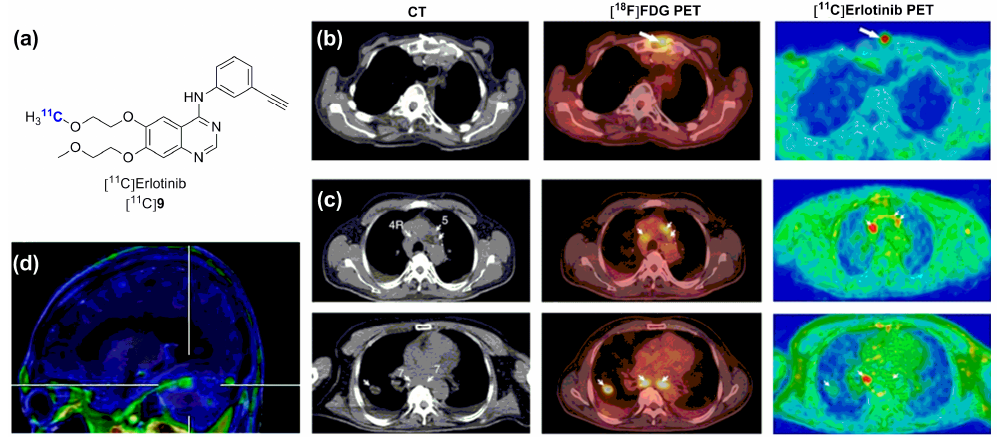
Figure 4. Selected in vivo results with [ 11 C]erlotinib. ( a ) Chemical structure of [ 11 C]erlotinib and comparative PET imaging studies; ( b ) Bone metastasis ( c ) and tumor/lymph node metastasis accumulation of [ 11 C]erlotinib in non-small-cell lung carcinoma (with CT and [ 18 F]FDG PET) (Figures in ( b , c ) adapted by permission from Macmillan Publishers Ltd on behalf of Cancer Research © , UK, [70] 2011); ( d ) Magnetic resonance imaging-PET image from [ 11 C]erlotinib accumulation in brain metastatic lesions in a patient diagnosed with a non-small-cell lung carcinoma. (CT: computed tomography) (Adapted by permission from [71], from the publisher Wolters